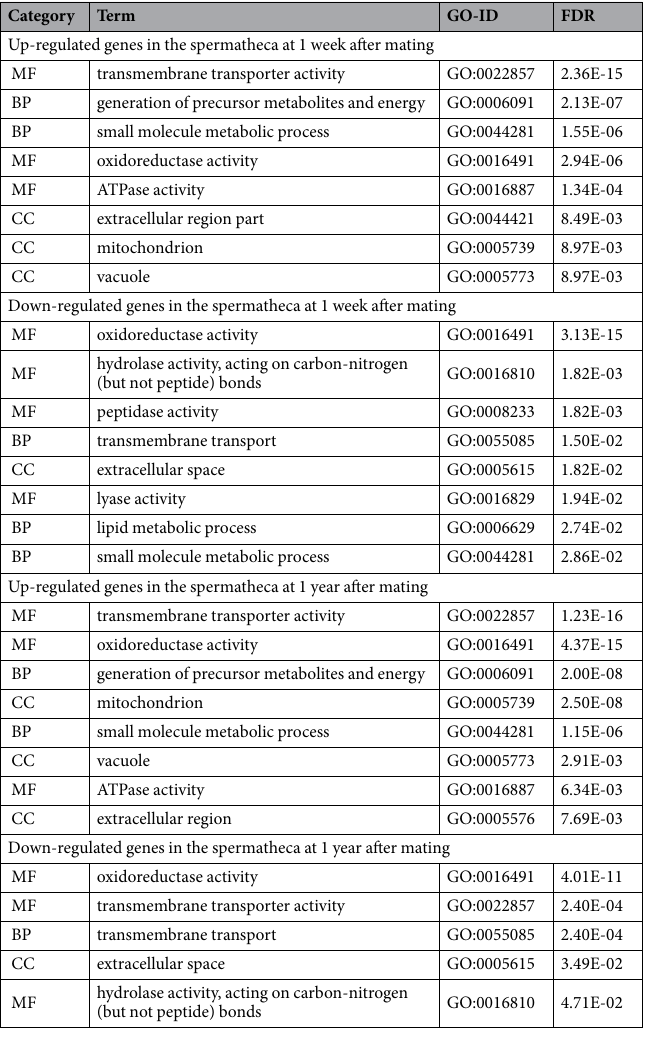
Table 2. Over-represented gene ontology terms among genes differentially expressed between the spermatheca and the body samples of queens after 1 week and 1 year of mating. Abbreviations: BP, biological process; MF, molecular function; CC, cellular